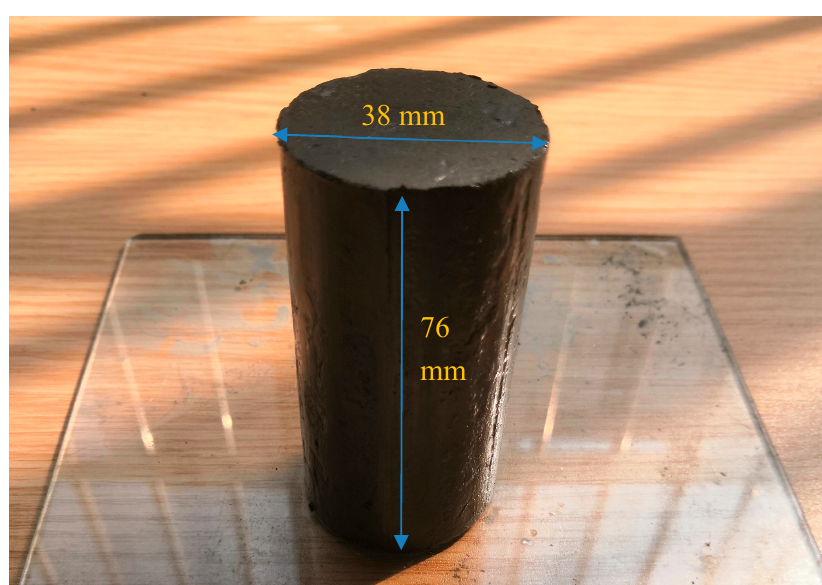
Figure 2. Remolded soil sample.